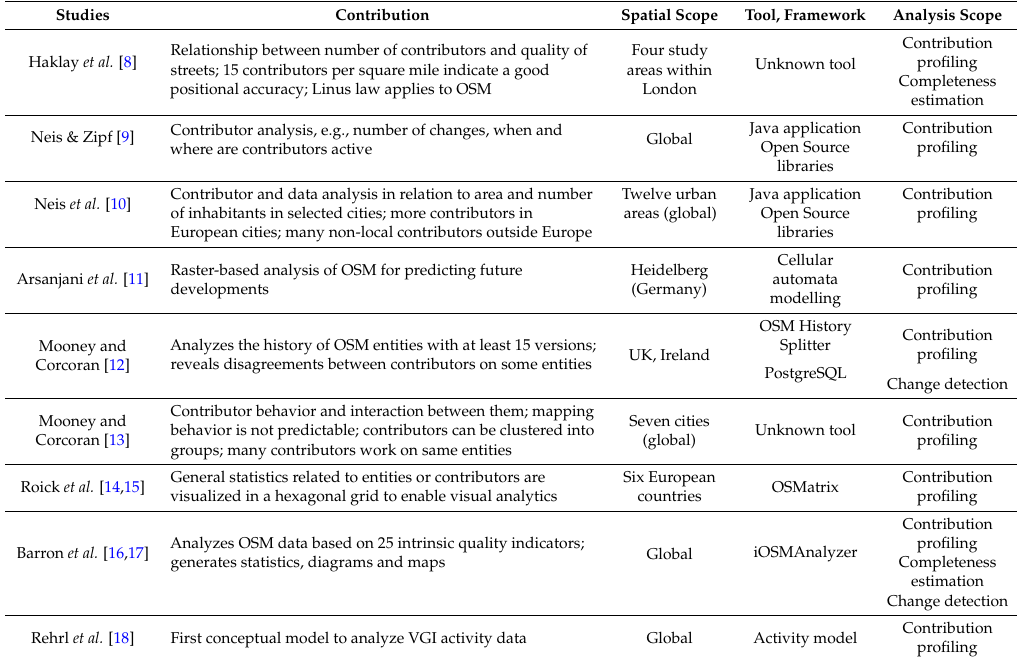
Table 1. Comparative overview of previous